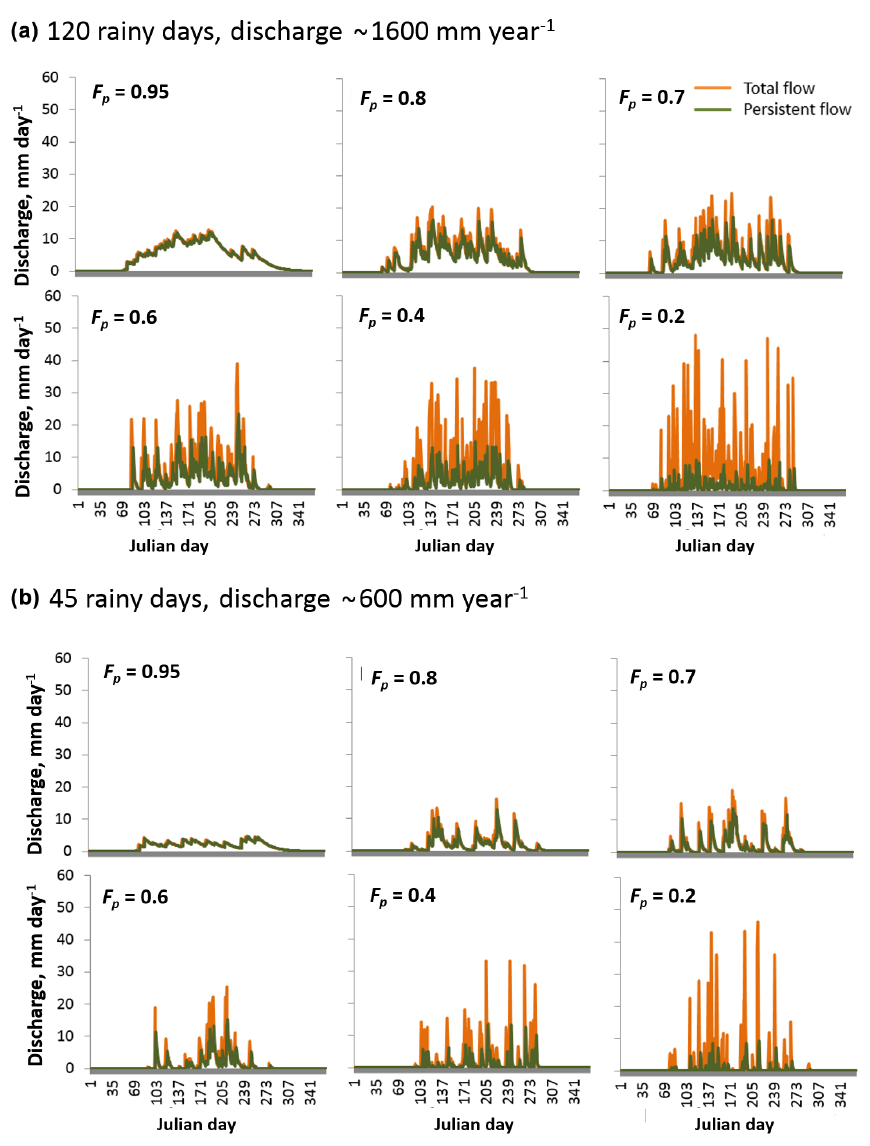
Figure 4. Effects of the F p parameter on hydrographs of daily river flow generated by a random rainfall generator, with persistent and additional flow components indicated, for two settings with total rainfall of approximately 1600 and 600mmyr − 1 (NB river flow is here expressed as mmday − 1 rather than as m 3 s − 1 as in Fig.